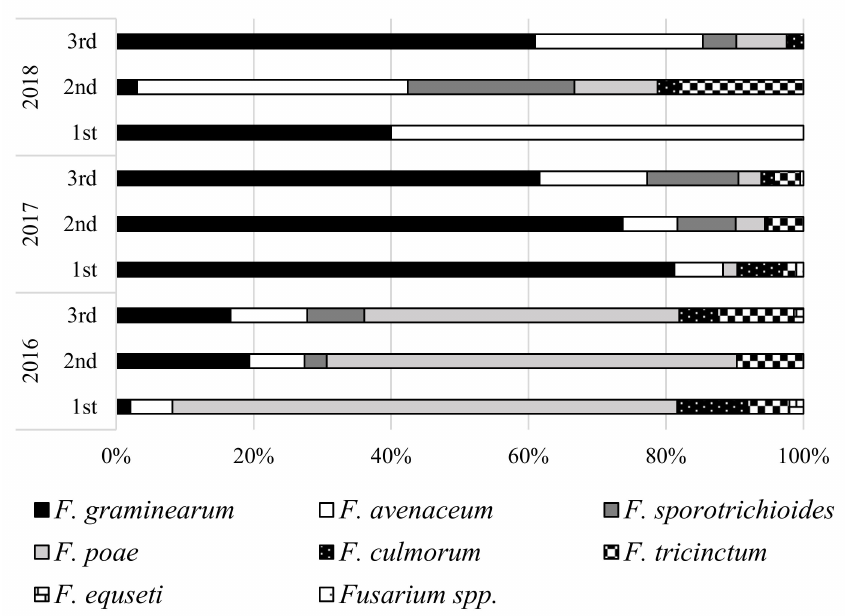
Figure 3. Fusarium species distribution (%) and composition in the grains of spring wheat at different harvesting times. Note. 1st—harvesting time when wheat reached full maturity (BBCH 89), 2nd—full maturity + 10 ± 2 days, 3rd—full maturity + 17 ± 3